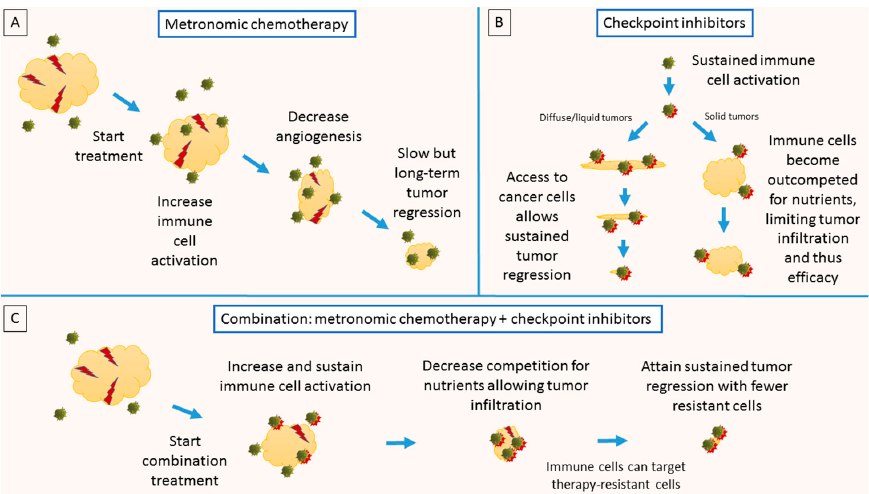
Figure 3. Synergistic effects of metronomic chemotherapy combined with checkpoint